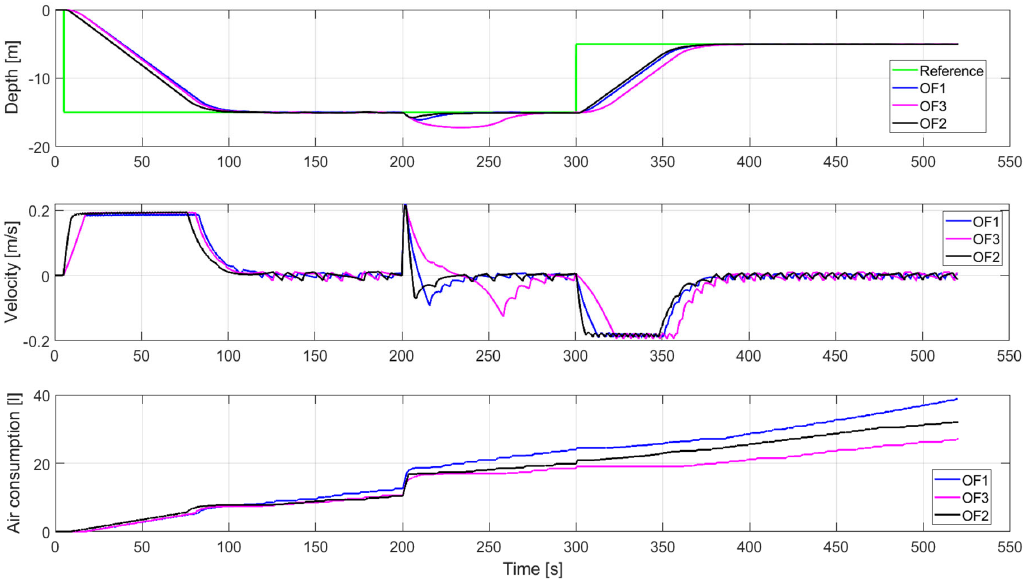
Figure 11. Velocity FLCS response obtained with all three objective functions after applying the disturbance.